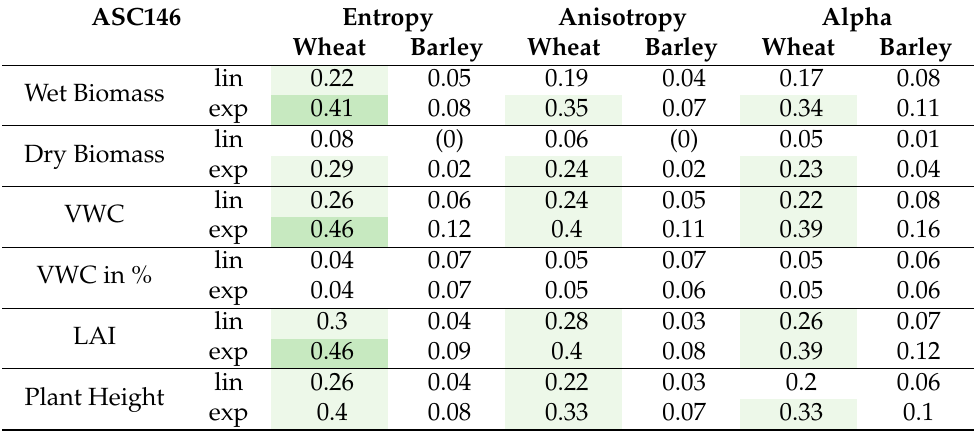
Table 3. R 2 values of the regression between crop and dual-polarimetric parameters per crop type for all fields: values in parentheses are not significant ( p > 0.01). The darker the shade of green, the higher the R 2 value.